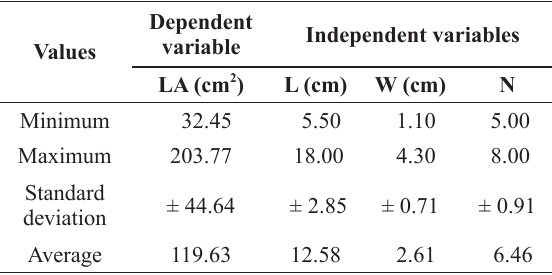
Minimum and maximum values, standard deviation and averages of leaf area (LA), length (L) of the central lobe, width (W) of the central lobe and the number (N) of lobes in cassava leaves, cultivar IAC 576-70, at 80 days after planting in the region of Botucatu, SP, Brazil.